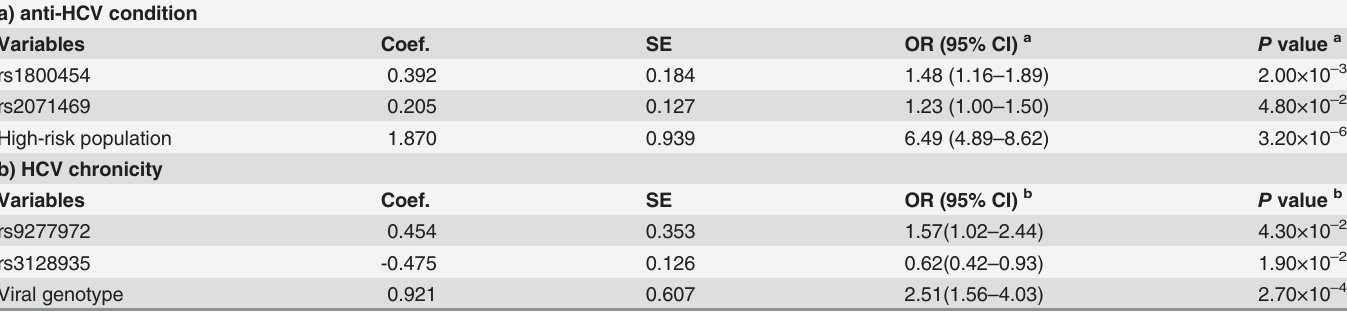
Table 3. Multivariate stepwise regression analysis for independent factors of HCV infection outcomes.